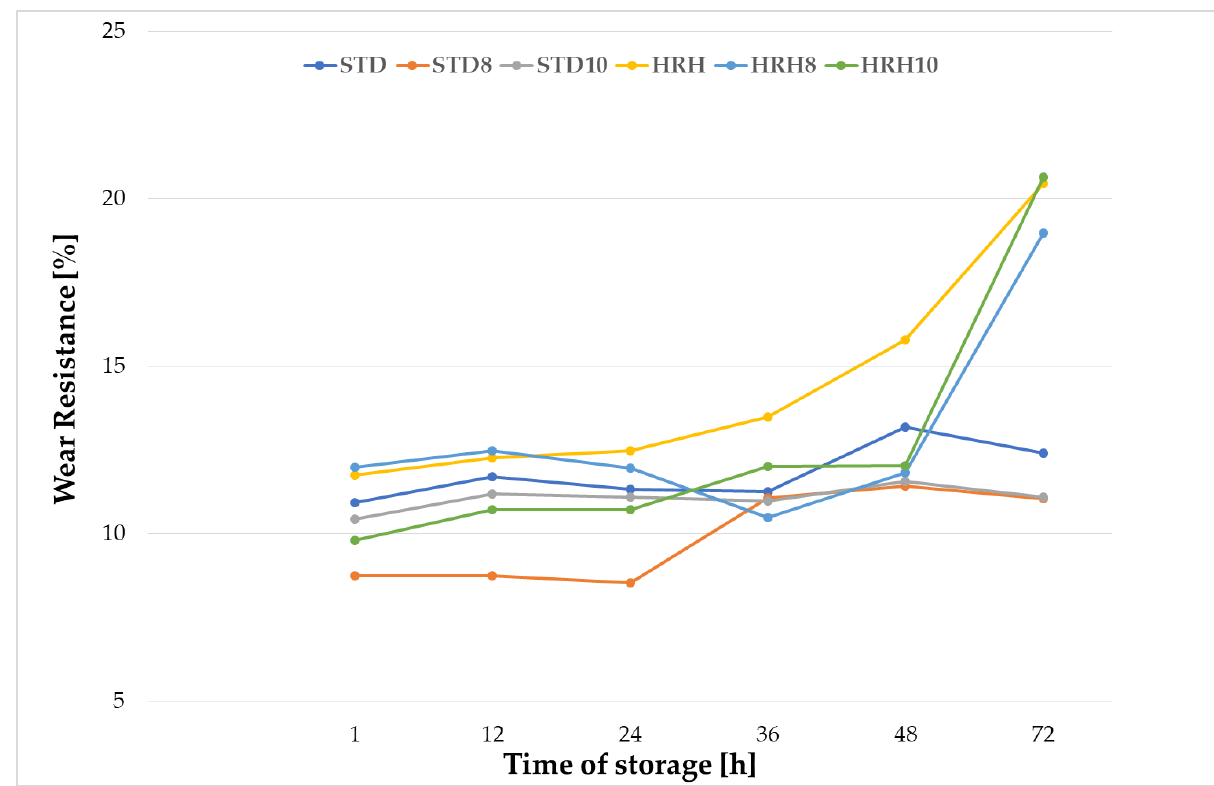
Figure 5. Wear resistance of cores depending on the time of storage under different storage conditions (different shooting pressures used within the core production): STD—Laboratory ambient conditions—RH = 60% ± 5%, t = 25 ◦ C, Shooting pressure 6 bar; STD8—Laboratory ambient conditions—RH = 60% ± 5%, t = 25 ◦ C, Shooting pressure 8 bar; STD10— Laboratory ambient conditions—RH = 60% ± 5%, t = 25 ◦ C, Shooting pressure 10 bar; HRH—High relative humidity, constant temperature—RH = 90% ± 5%, t = 25 ◦ C, Shooting pressure 6 bar; HRH8—High relative humidity, constant temperature—RH = 90% ± 5%, t = 25 ◦ C, Shooting pressure 8 bar; HRH10—High relative humidity, constant temperature— RH = 90% ± 5%, t = 25 ◦ C, Shooting pressure 10 bar.